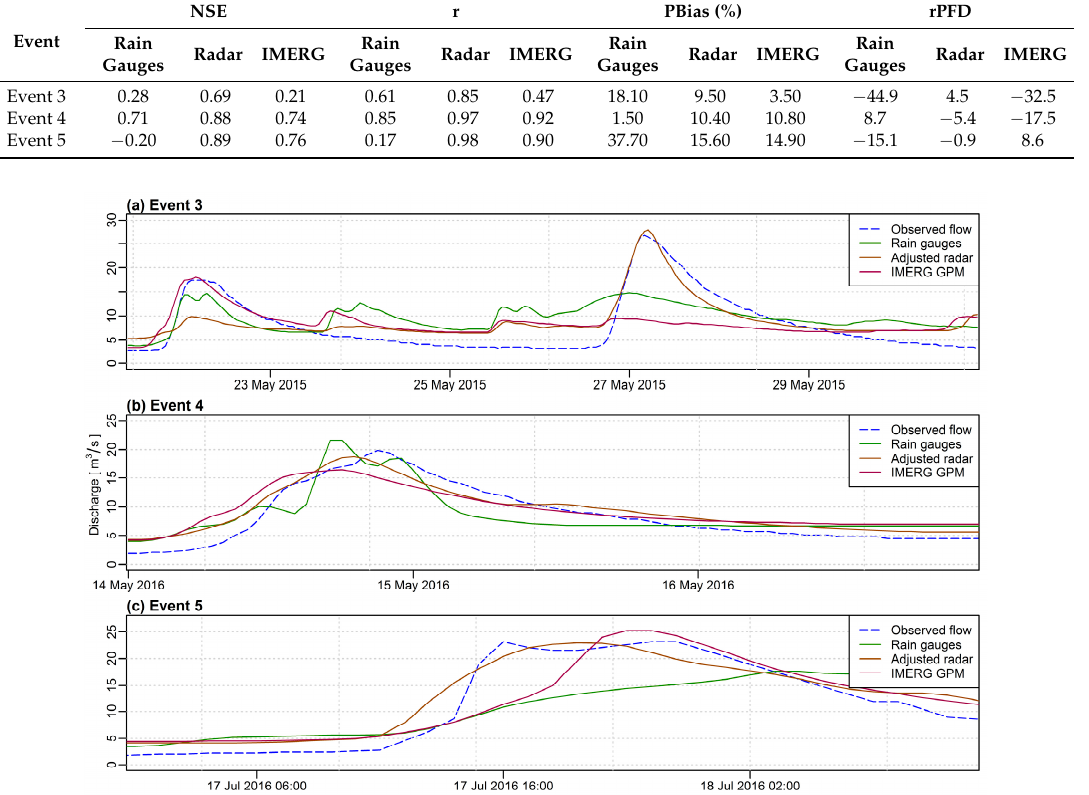
Table 11. The results of the evaluation criteria for validation events.